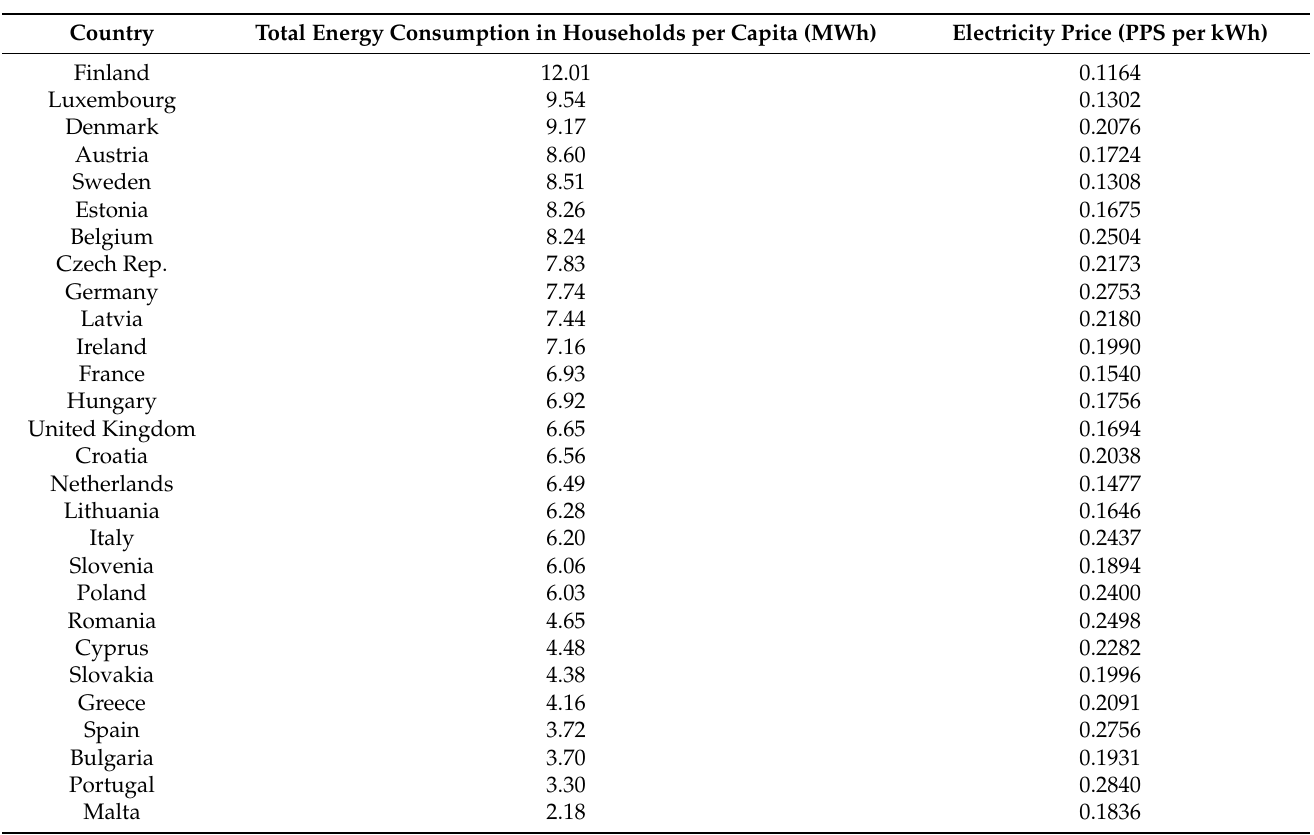
Table 1. Household energy consumption per capita 2018 (MWh) and electricity prices components for household con- sumers